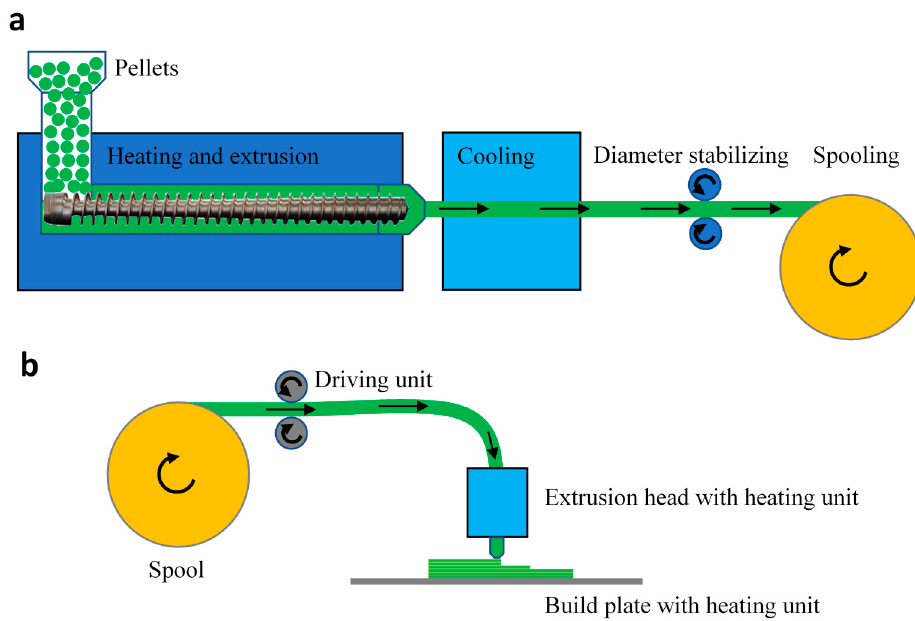
Figure 1. Schematic illustration of the cycle from pellets to printed product: ( a ) 3-D printing filament extrusion process and ( b ) fused deposition modeling (FDM).